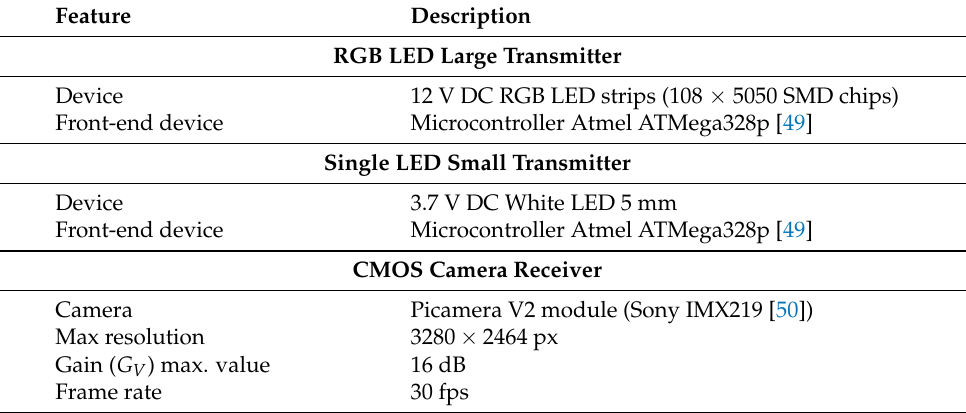
Table 1. Description of the T x and R x key